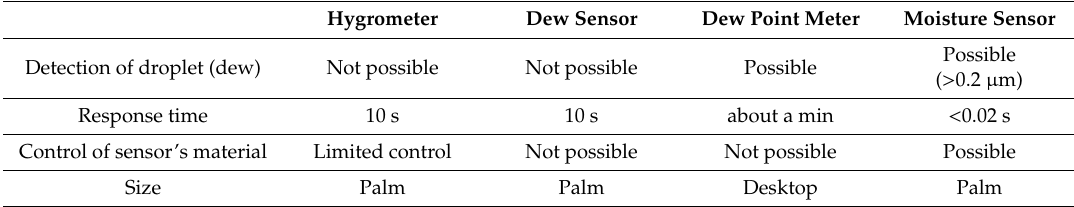
Table1. Comparisonofvariouscommercialsensorsusedformeasuringhumidityanddewcondensation with a moisture